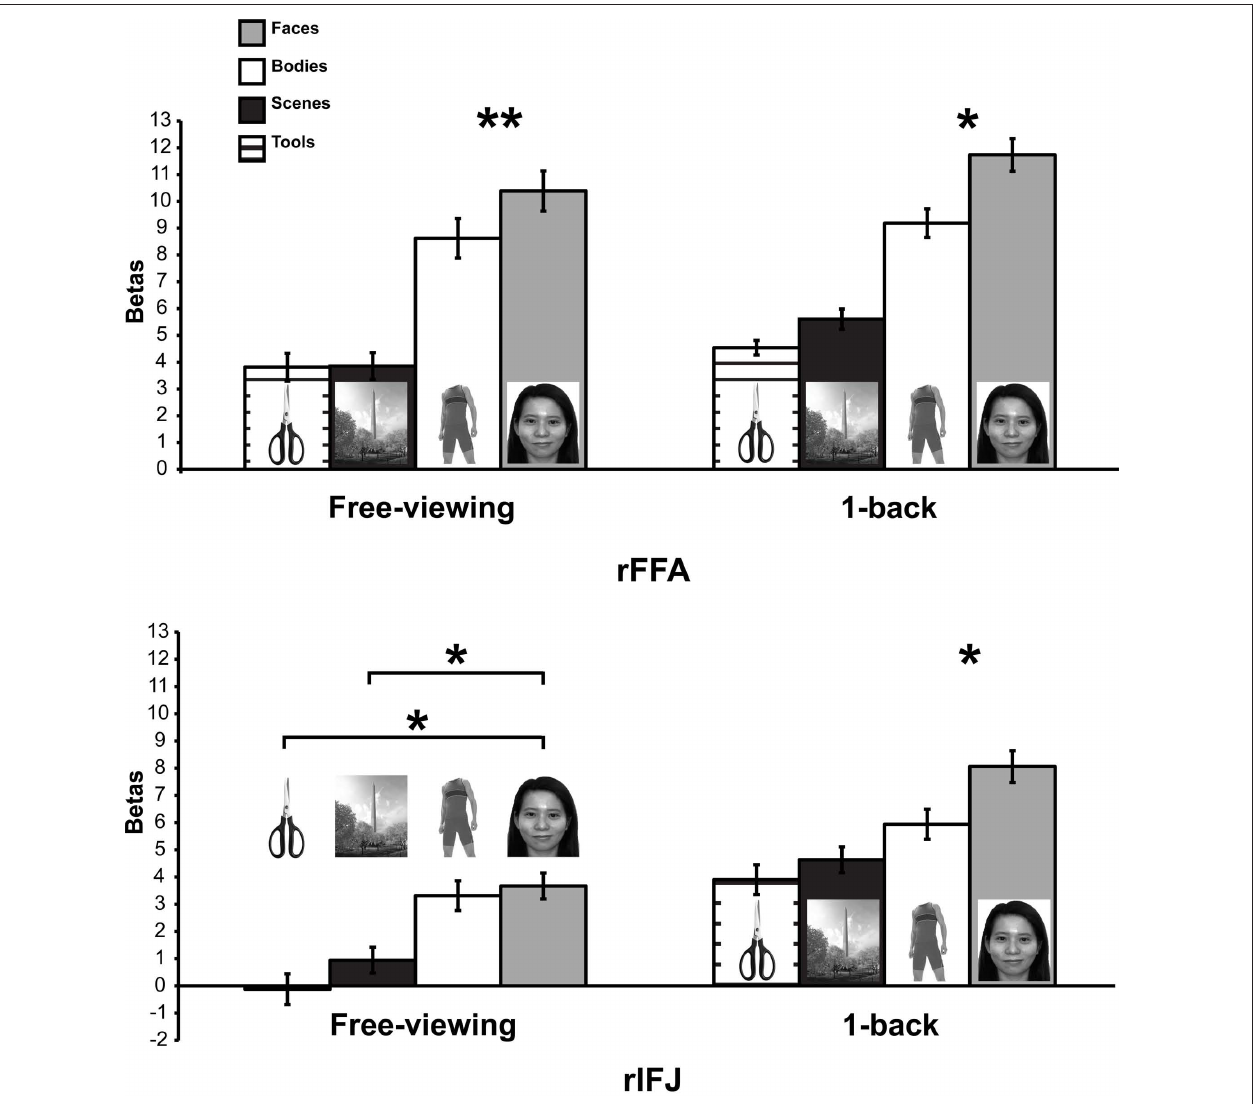
FIguRe 2 | Results of experiment 1. Responses of rFFA and rIFJ, based on independent functional localizers, to faces, headless bodies, tools, and outdoor scenes, in both free-viewing and 1-back tasks. Response magnitudes indicate beta weights from general linear models fit to the aggregate data from each region of interest. Error bars indicate standard error of the mean. Asterisks indicate significant differences between conditions: * p < 0.05; ** p